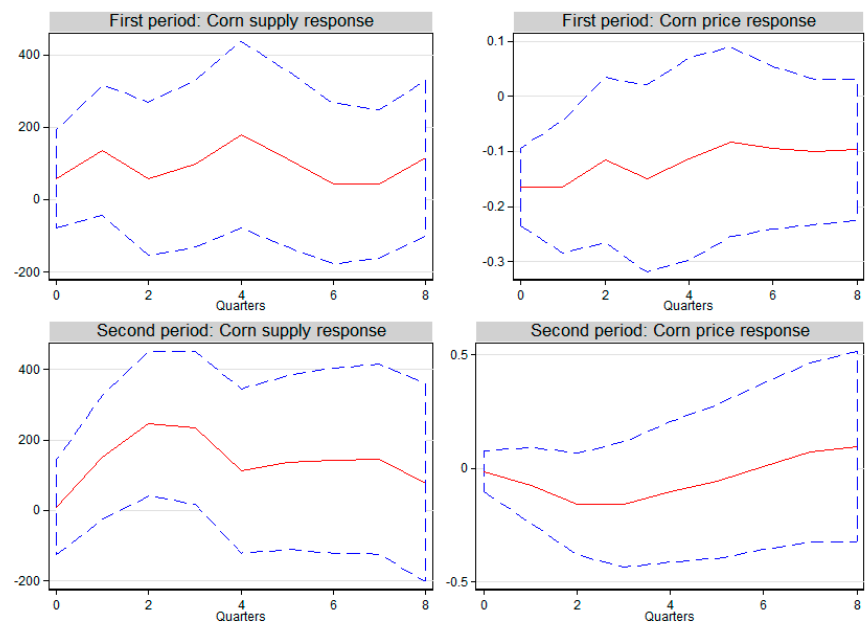
Figure 5. Response of corn supply and corn price to corn use in ethanol shocks. Notes: Red lines represent cumulative orthogonalized impulse–response functions while blue lines represent 95% confidence intervals.